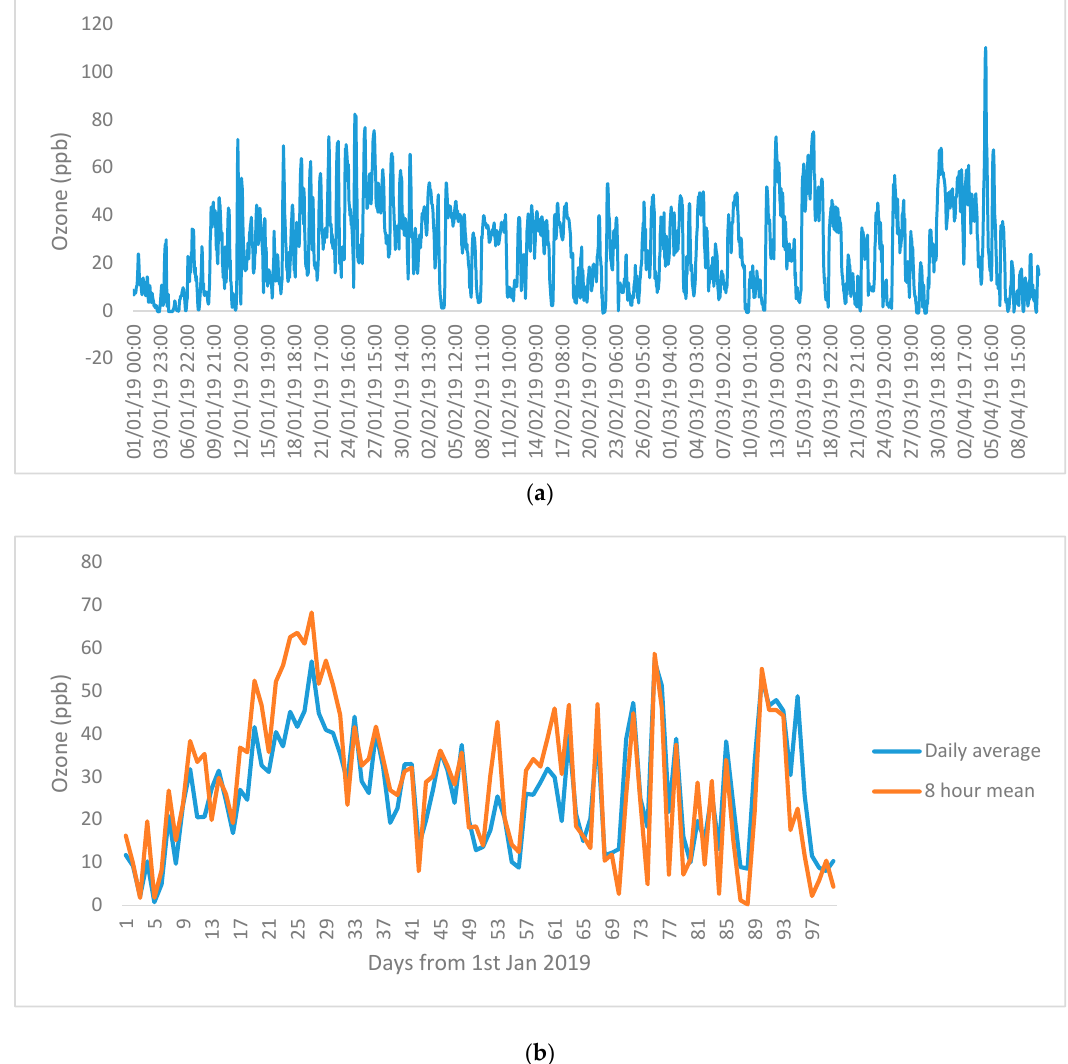
Figure 3. ( a ) Hourly ozone level in ppb and ( b ) daily mean O 3 and 8 h mean ozone (9 a.m. to 5 p.m.) recorded at the Ozone Garden (latitude 22.4248° and longitude 114.2068°) from 1 January to 10 April 2019 using a Teledyne 400 ozone analyzer.